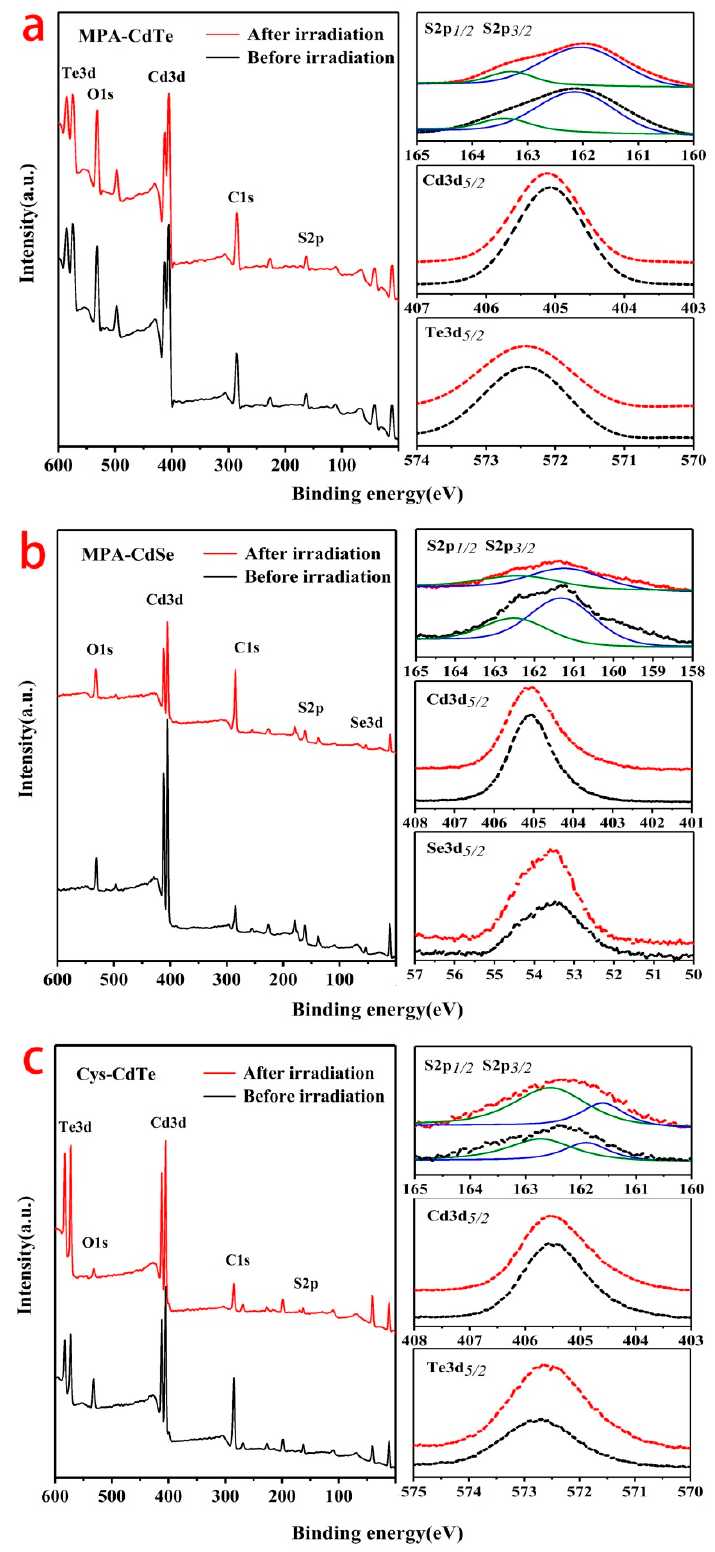
Figure 7. XPS spectra of MPA-CdTe ( a ), MPA-CdSe ( b ) and Cys-CdTe ( c ) QDs before and after 10 kGy irradiation.